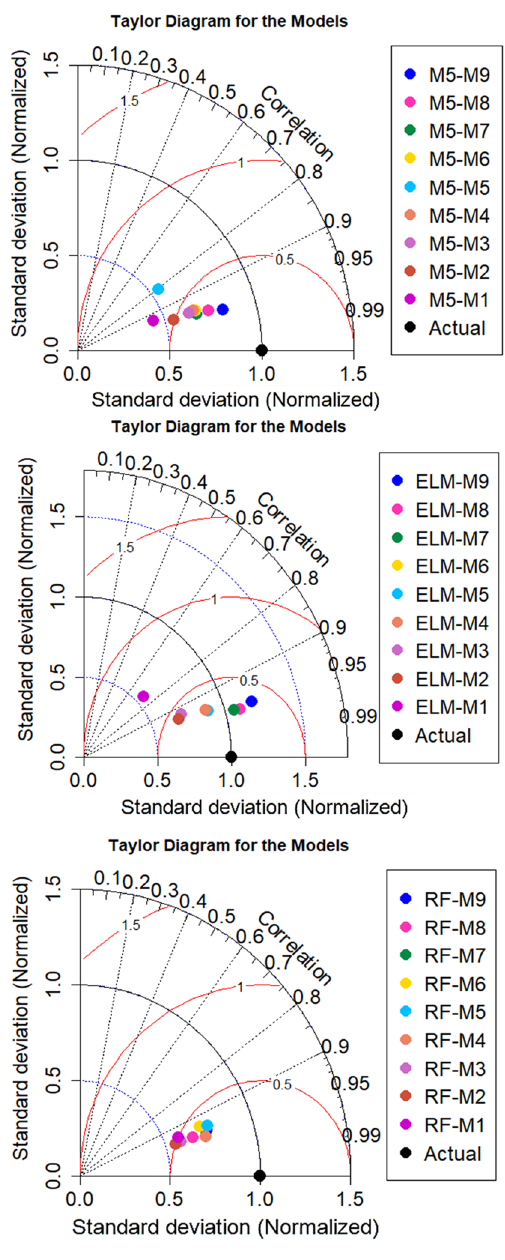
Figure 7. Taylor representation of ML models for testing